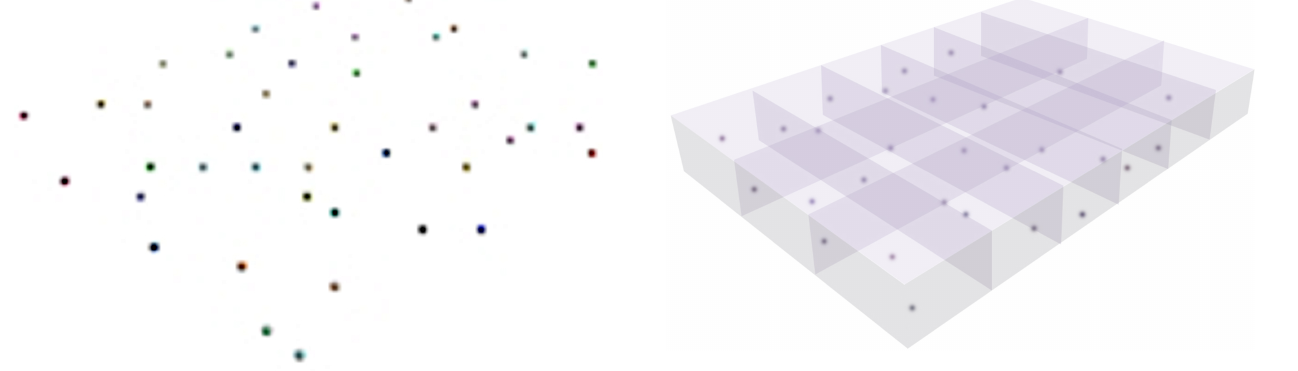
Figure 7. A sample of point set.